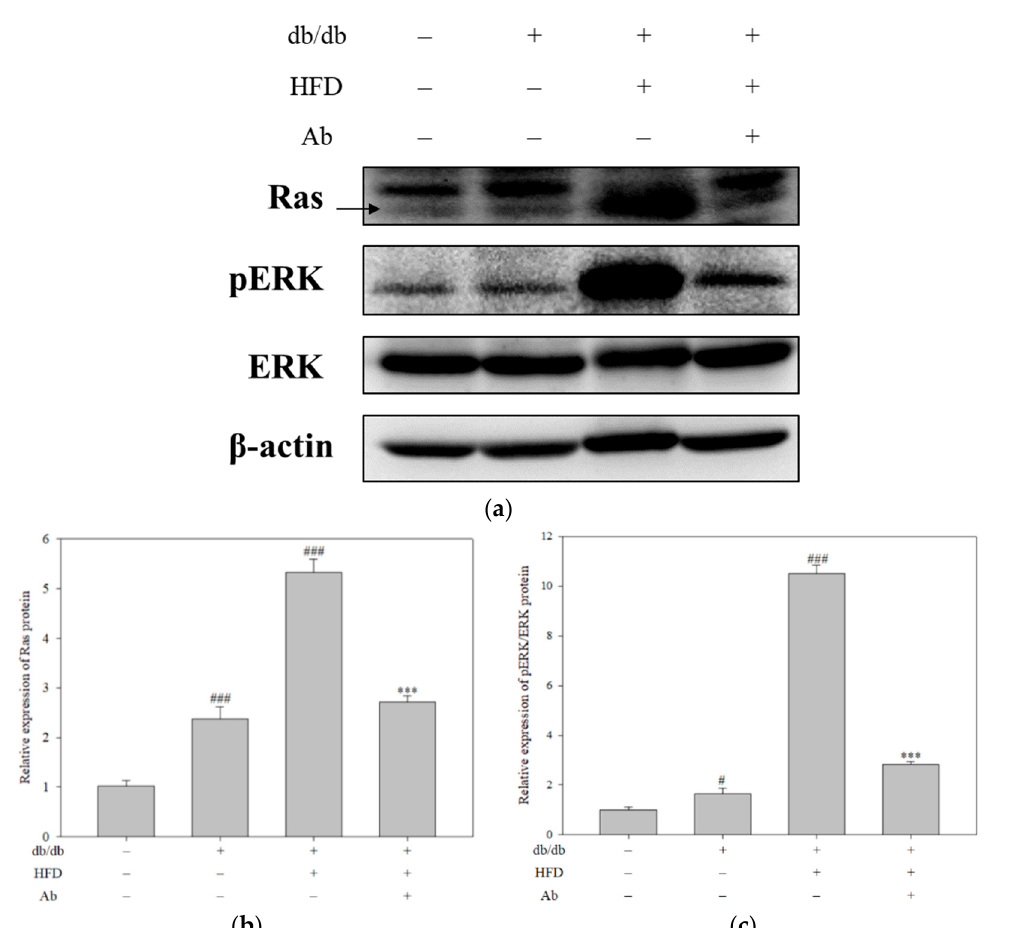
Figure 6. Ab decreased the expression of Ras-related proteins in the kidney. The expression of Ras-related protein in the kidney was detected through Western blotting. The renal tissue was derived from C57BL/6 mice, db/db mice, db/db mice with HFD, db/db mice with HFD, and Ab. ( a ) The results were analyzed using Image-Pro plus and displayed. Quantification of ( b ) Ras protein expression and ( c ) the pERK/ERK protein expression. β -actin was used as a loading control. Data are presented as mean ± SD from three samples for each group. The results were analyzed with Student’s t -test. # p < 0.05, ###, p < 0.001 compared with the control group. ***, p < 0.001 compared with the db/db+HFD group.